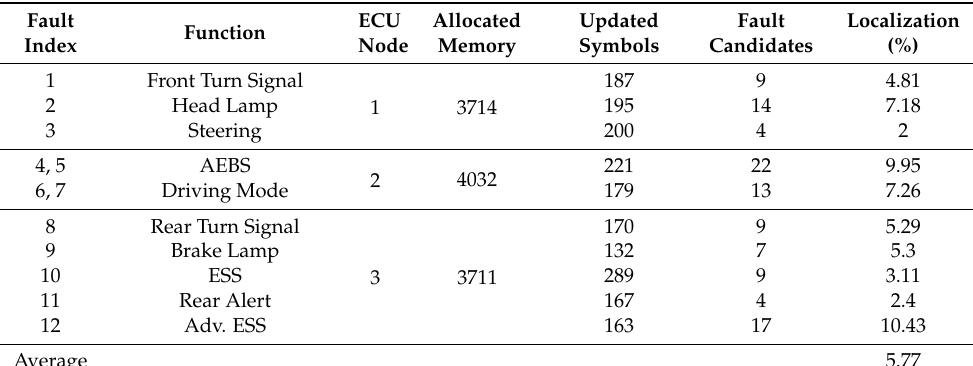
Table 5. Experimental result.